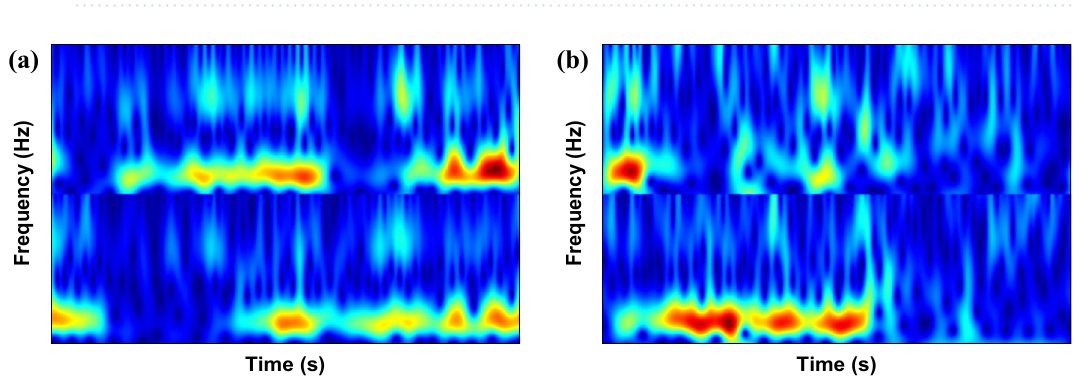
Figure 6. Demonstration of stacking TFMs from dataset II-III. ( a ) right-hand, and ( b )